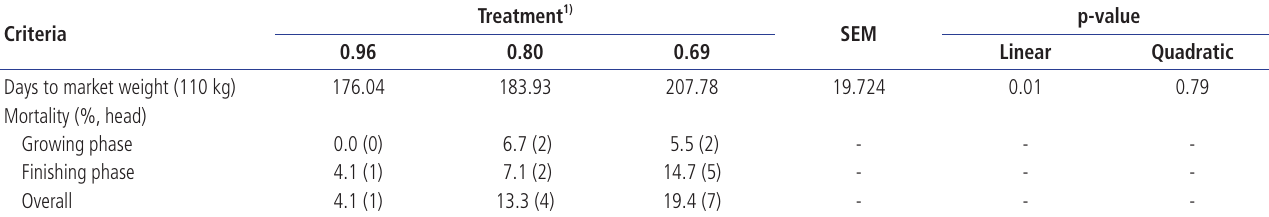
Table 7. Effect of different space allowance on mortality and days to market weight